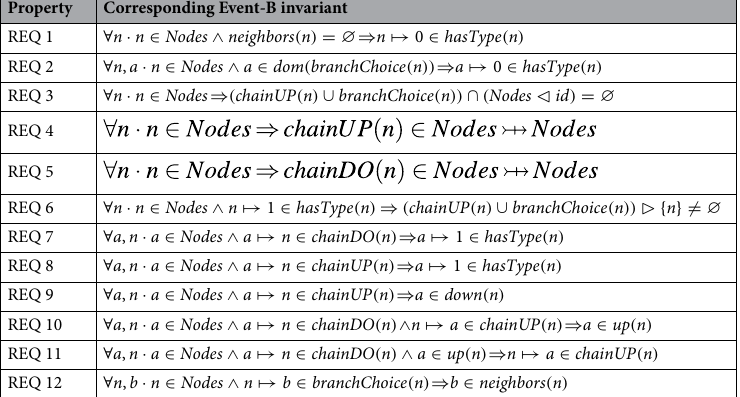
Table 1. Formal modeling of CBL properties with Event-B as